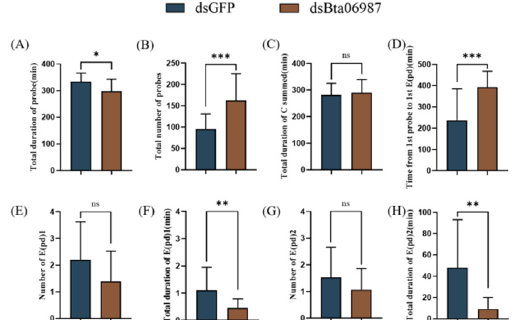
Figure 6. Feeding behavior of whiteflies. ( A ): Total duration of probes; ( B ): total number of probes; ( C ): total duration of C; ( D ): time from the first probe to the first E(pd); ( E) : number of E(pd)1; ( F ): total duration of E(pd)1; ( G ): number of E(pd)2; ( H ): total duration of E(pd)2. The data are shown as means ± SE with 15 independent experiments. Significant differences based on repeated measures ANOVA are denoted as * p < 0.05, ** p < 0.01, and *** p < 0.001. No significant differences based on Student’s t -test are denoted as ns.